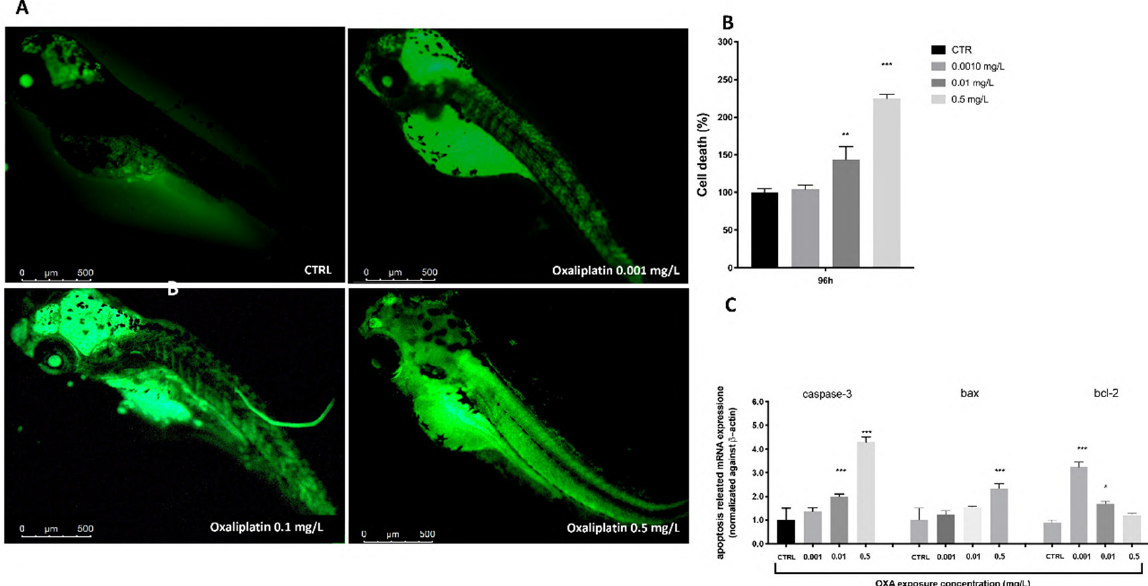
Figure 4. The OXA exposure effects on cell death zebrafish embryos. At 96 hpf, OXA 0.001, 0.1, 0.5 mg/L exposure, the levels of cell death were observed and photographed by a fluorescence microscope after staining with acridine orange ( A ). Percentage of cell death histogram ( B ). The results are expressed as mean of three independent experiment data. Related gene expression levels of apoptotic pathway in zebrafish embryos exposed to OXA at concentrations of 0.001, 0.1, 0.5 mg/L at 48 hpf ( C ). The fold change from the CTRL group is used to reflect the mRNA expression levels. * p < 0.05, ** p < 0.01, *** p < 0.001 versus control. Scale bars 4× magnification.